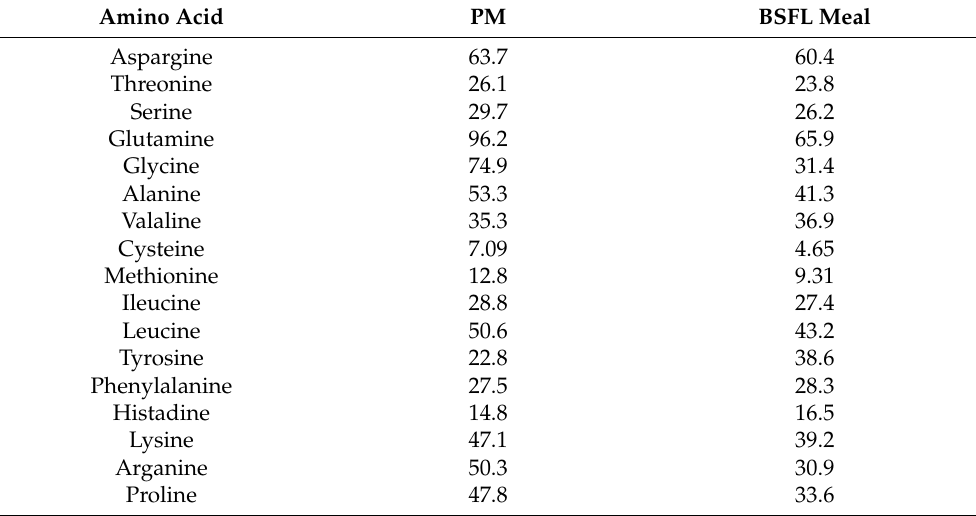
Table 4. Levels of amino acids in the experimental raw ingredients (g/kg DM).